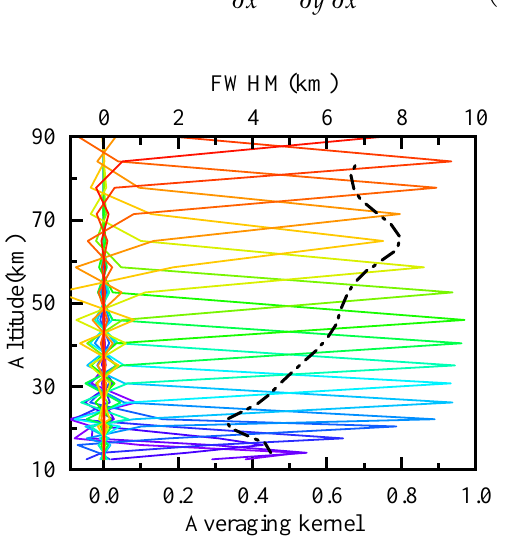
Figure 11. The vertical resolution of the H 2 O retrieval for 60 ◦ –65 ◦ S in